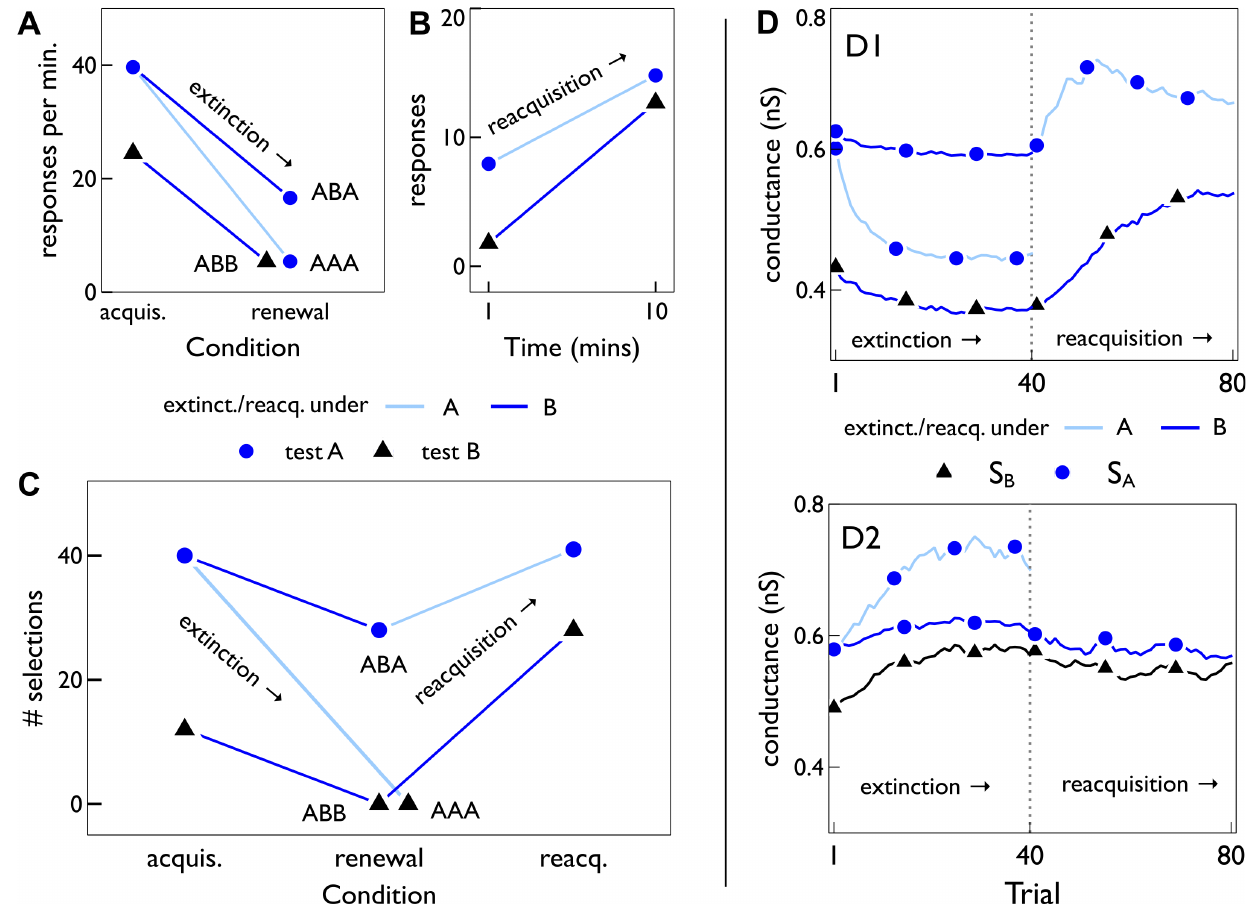
Figure 8. Extinction, renewal, and reacquisition. (A) Summary of relevant data from Figure 3 in [49], (see Methods for interpretation of that data) showing renewal effects after sequence ABA , but not after control sequences AAA and ABB . The points labelled ‘‘acquis.’’ are the performance before extinction in the same context as the renewal test, giving a baseline for the performance change caused only by any switch in context after extinction. In all of (A–C), the blue/black symbols correspond to testing with contexts A = B . (B) Summary of relevant data from [50] (see Figure 2 therein), showing reacquisition of responding in two contexts A , B , after original acquisition in A and extinction in B . The symbols show endpoints of linear regressions through the original data, which include outcomes at several intermediate time points. (C) Behavioural responses of the basal ganglia model with MSNs initially trained with context A . The acquisition (‘‘acquis.’’) is tested near the end of the intermission period for two contexts, A , B , derived using different strong-afferent synaptic sets S A , S B (see text for details). The renewal is tested at the end of 40 trials of extinction under both contexts, leading to the renewal sequences ABA , ABB , and AAA . Reacquisition is measured after 40 learning trials, under each context. (D) Shows (for both D1- and D2-MSNs) the mean AMPA conductance of synaptic sets S A , S B against trial number, during extinction (trials 1–40), and reacquisition (trials 41–80) under the behavioural protocols in (C). Trials are numbered from trial 80 near the end of the intermission period in the simulated experiment (Figure 7). The trajectory for S A under extinction with A (pale blue line, dark blue symbols) is identical to the extinction shown in Figure 7. the model’s behavioural performance following the subsequent reintroduction of reinforcement is consistent with the data in Figure 8B: requisition allows increased selection, and the ordering under both contexts is preserved.